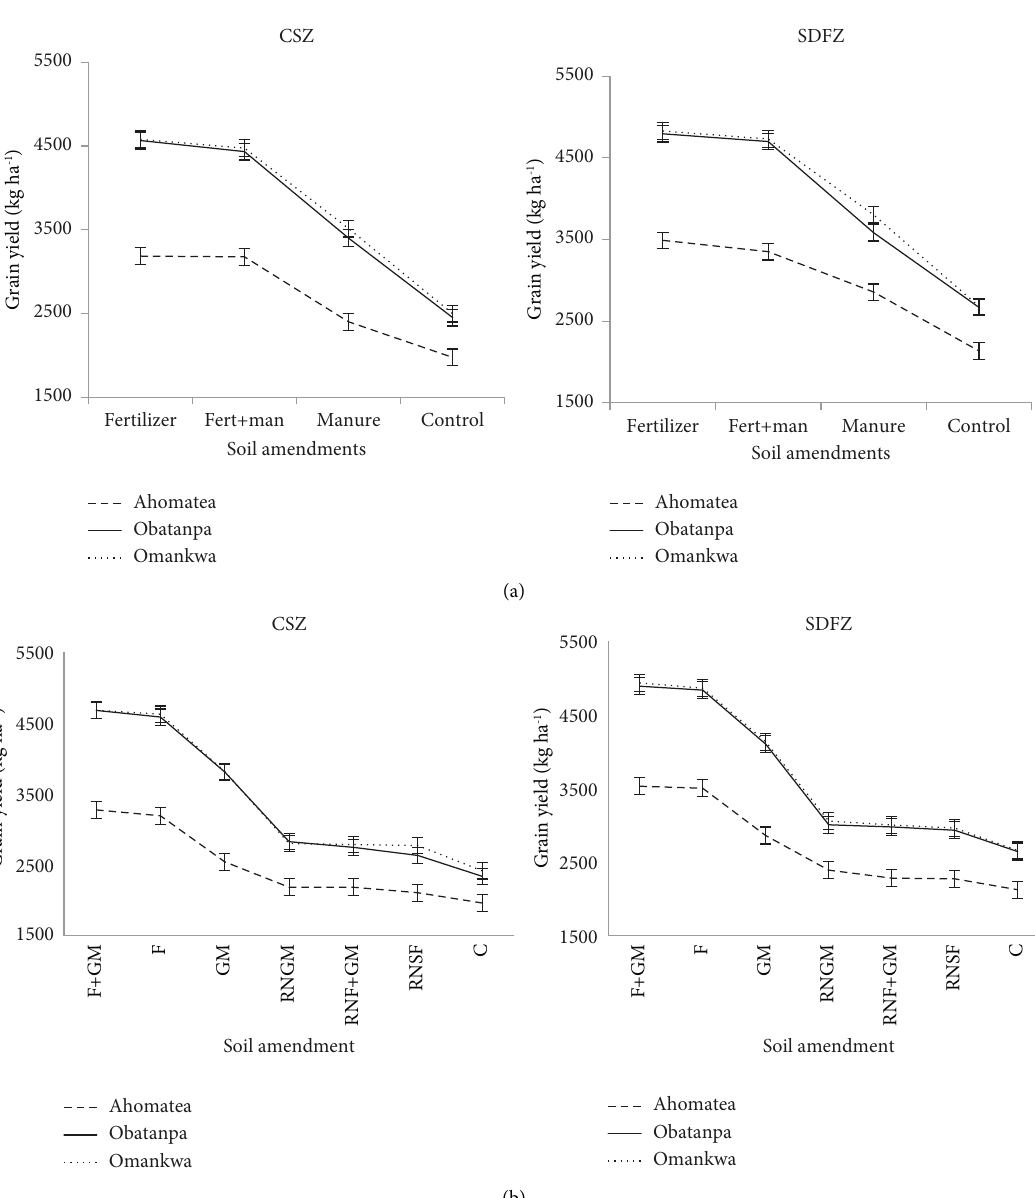
Figure 4: (a) Grain yield (kg ha − 1 ) of three maize varieties under diferent soil amendments in the coastal savannah (CSZ) and semi deciduous forest zones (SDFZ) in the major cropping season of 2017. (b) Grain yield (kg ha − 1 ) of three maize varieties as infuenced by residual efects/application of soil amendments in the coastal savannah zone (CSZ) and semi deciduous forest zones (SDFZ) in the minor cropping season of